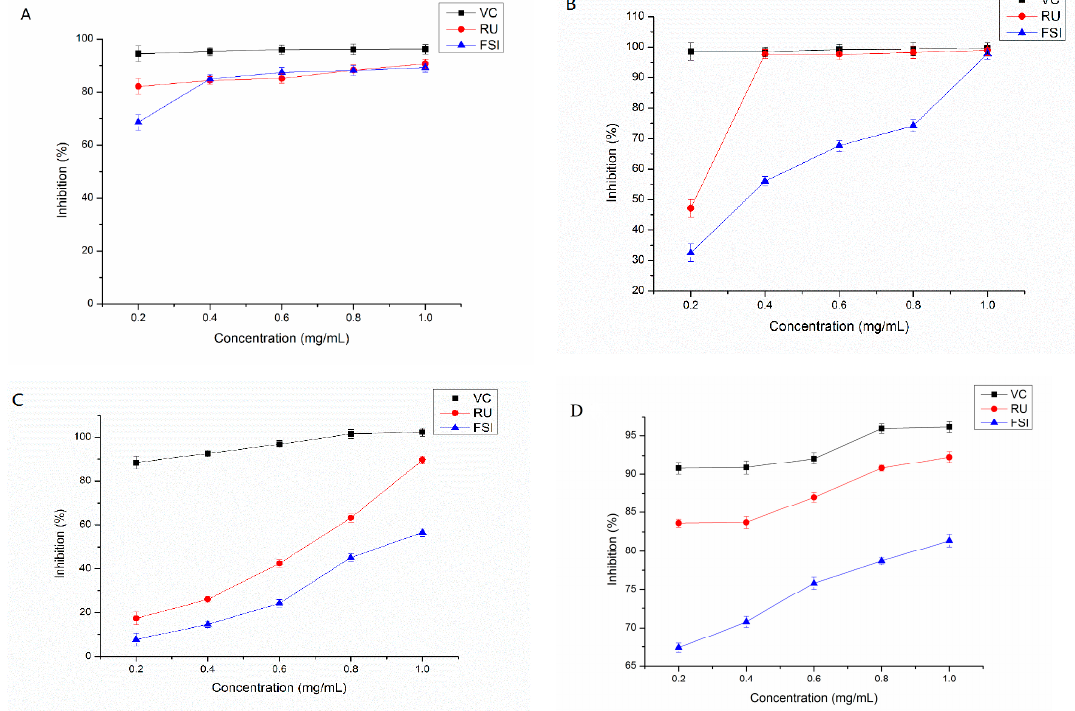
Figure 8. Effect of gradient concentration of FSI extracts of in antioxidant capacity tests: ( A